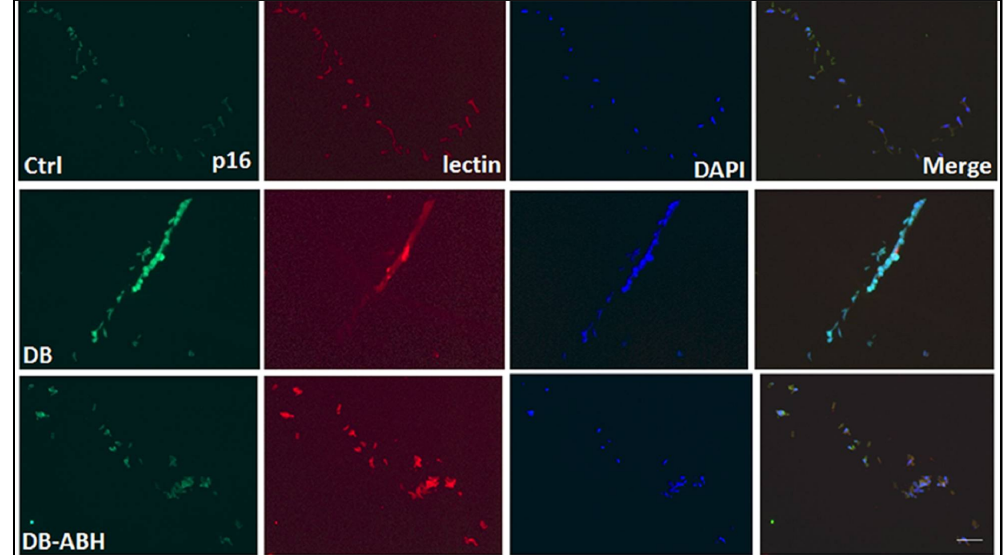
Figure 4. Arginase inhibition reduces p16 expression in isolated vessels. Immuno-labeling of isolated retinal vessels showing expression of the senescence protein p16 (green) in vascular endothelial cells which was co-localized with the endothelial marker (isolectin B4, red). Diabetic vessels showed increased p16 expression compared to controls. Arginase inhibition with ABH significantly reduced p16 expression. n = 3–4. Scale bar = 50 µ